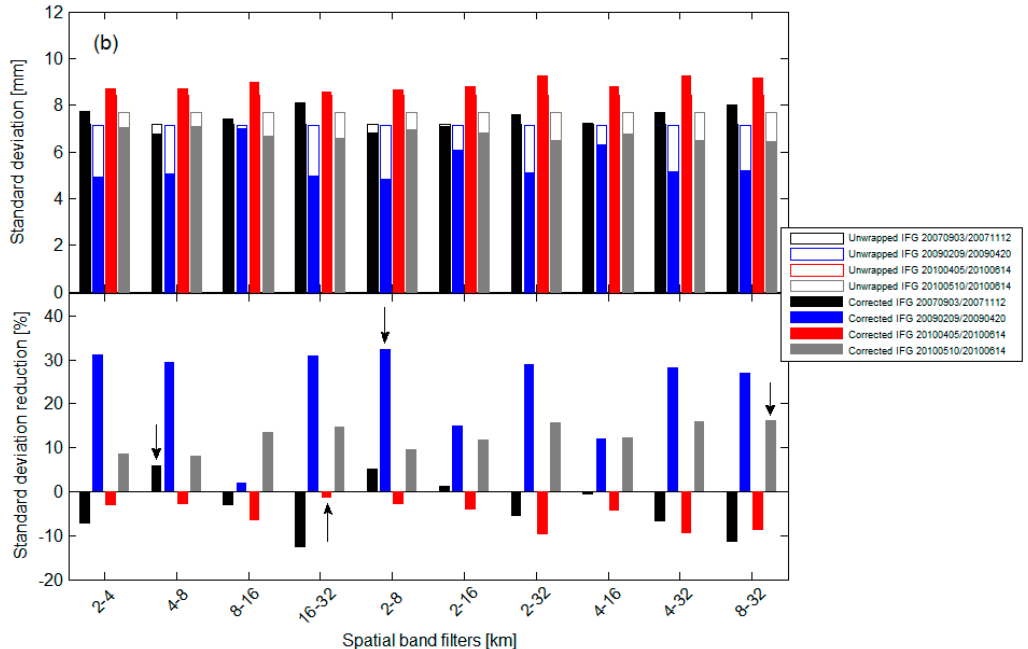
Figure 5. Comparison of mitigation results of different spatial bands for each interferogram in: ( a ) California; and ( b ) Tianshan. The different color bars represent different interferograms. Upper panel represents STD of the unwrapped interferograms (hollow bars) compared to the residual STD after correcting the tropospheric delay derived from the PLE method (filled bars). Lower panel represents reduction of STD after delay correction of different spatial band filters. Arrows were selected for each interferogram to indicate the bands with the largest reduction in STD.